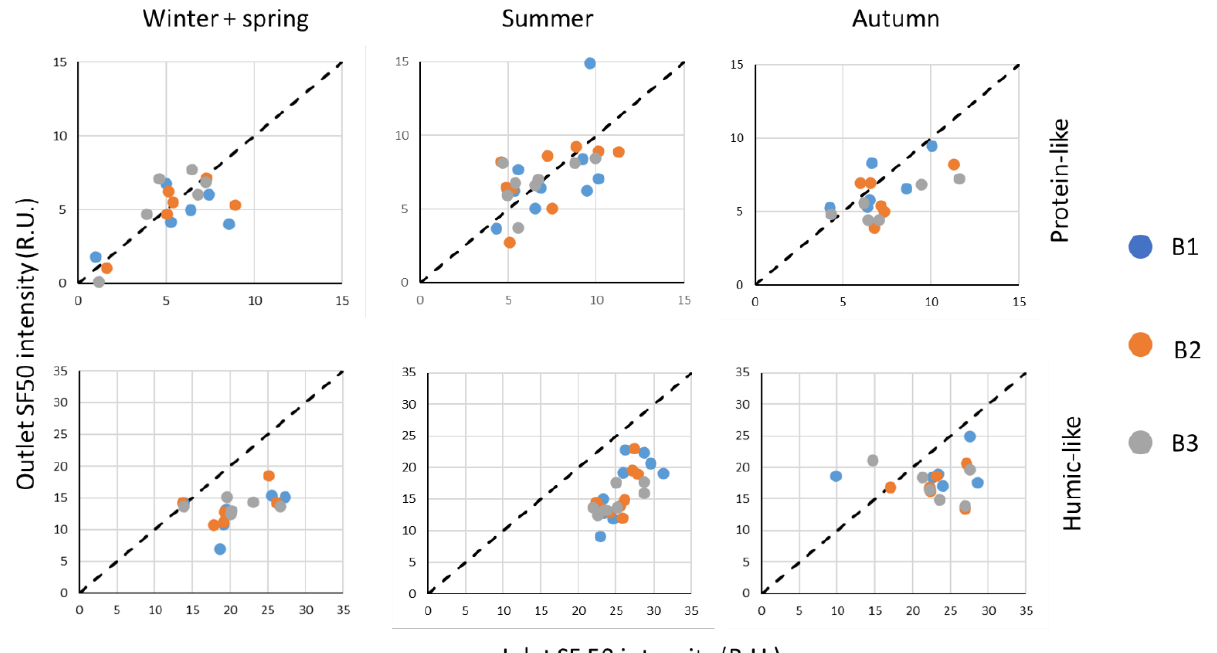
Figure 10. Comparison of protein-like and humic-like SF50 intensities at the outlets versus the inlets of the three basins as a function of the season.